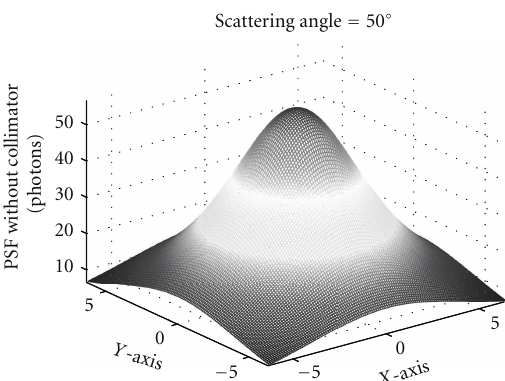
Figure 13: The PSF at a scattering angle of 50 degrees without collimator (reprinted with permission from [20]).